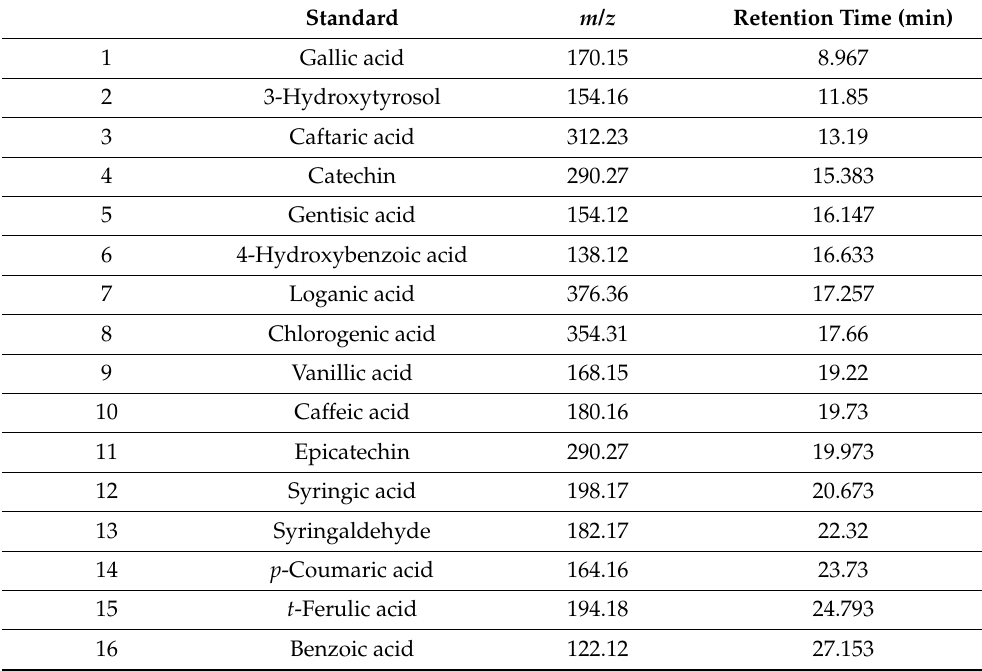
Table 3. Mass to charge ( m / z ) ratios, retention times, and quantities of the investigated phenolic compounds. DAD detector was set at 254